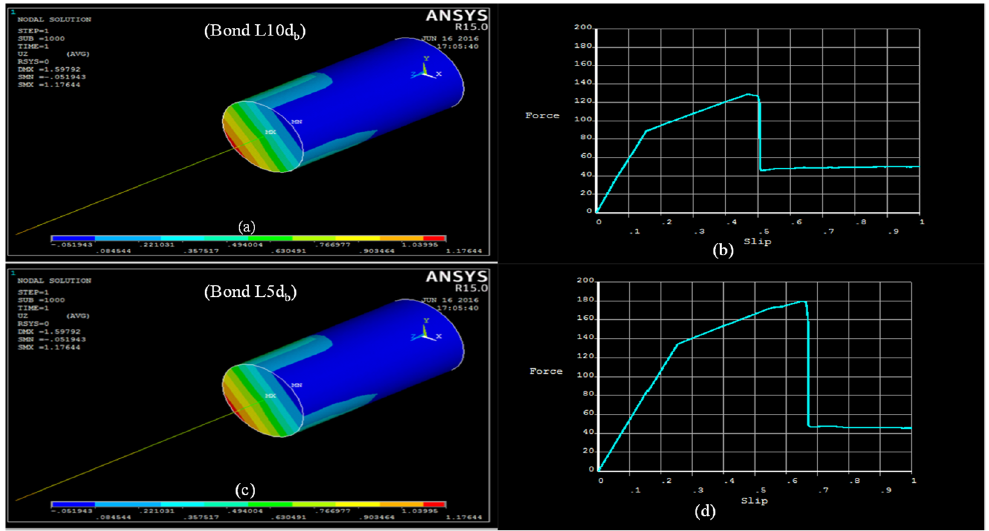
Figure 8. Stress of #13 diameter bar at failure and the generated curve ( a , b ) for bond 10 d b and ( c , d ) for bond 5 d b .